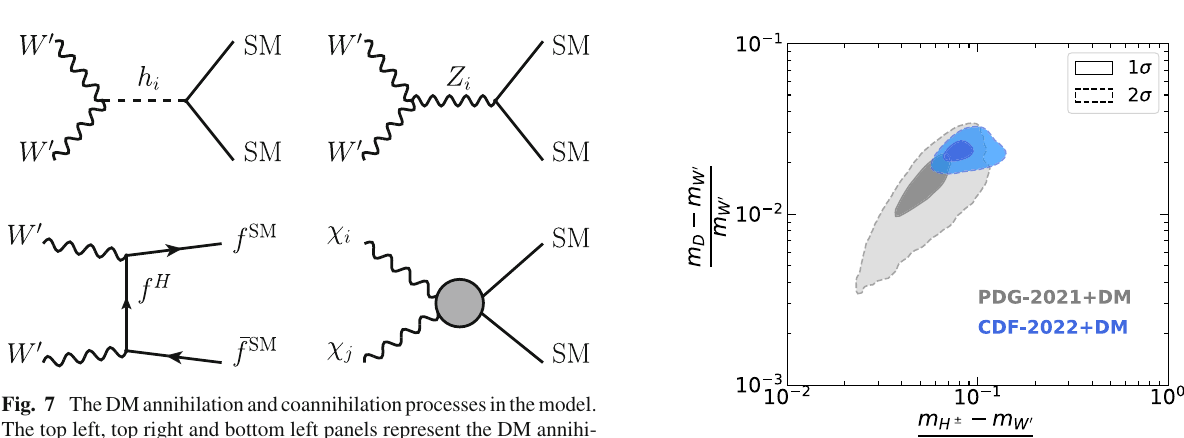
Fig. 6 The favored regions projected on the planes of ((cid:5) m ≡ m H ± − m D ,θ 2 ) (left panel) and ( m W (cid:3) , m H ± ) (right panel) for the heavy DM mass scenario. The dark (light) orange region represents the 1 σ (2 σ ) favored by CDF-2022 , while the dark (light) gray region indicates the 1 σ (2 σ ) favored by PDG-2021